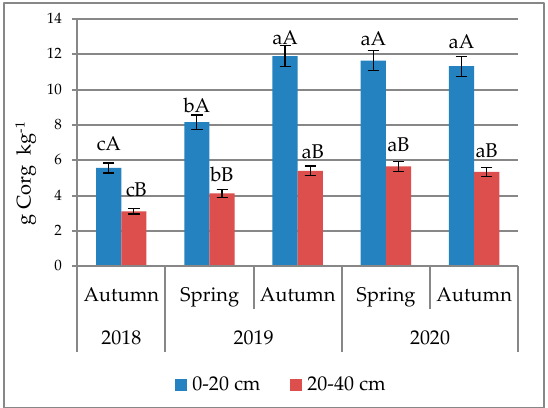
Figure 1. Content of organic carbon (Corg) in the studied soil. Different lower-case letters indicate significant differences among the soil sampling seasons (2018 autumn, 2019 and 2020 spring, autumn). Different upper-case letters indicate significant differences among levels of sampling. Error bars represent standard deviation.